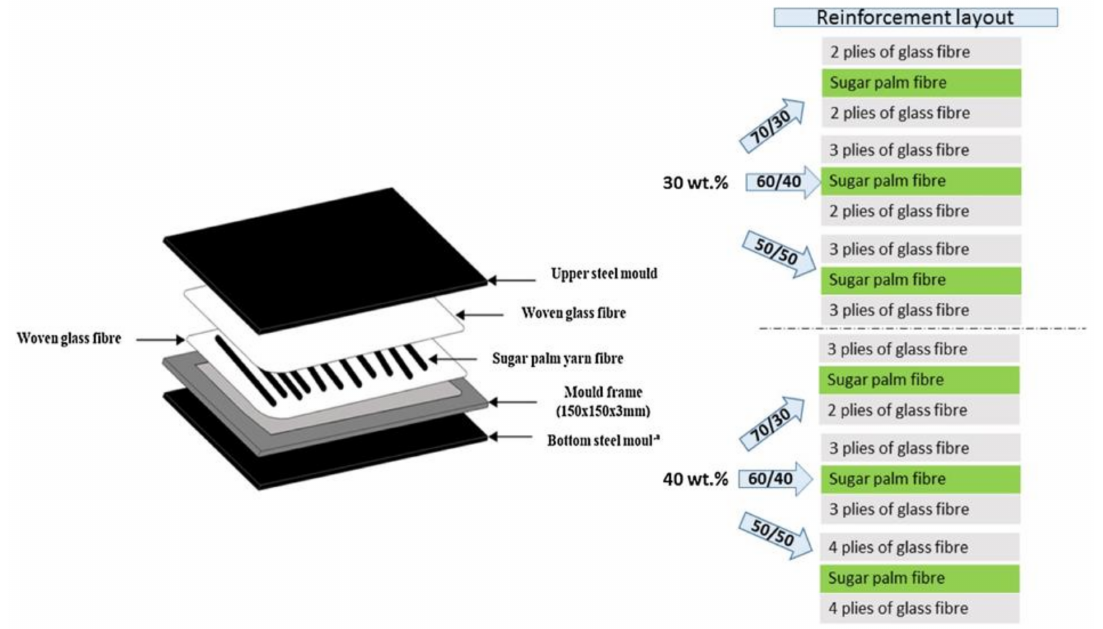
Figure 3. Schematic diagram of layup segmentation and reinforcement layout [139]. Extracted with permission from